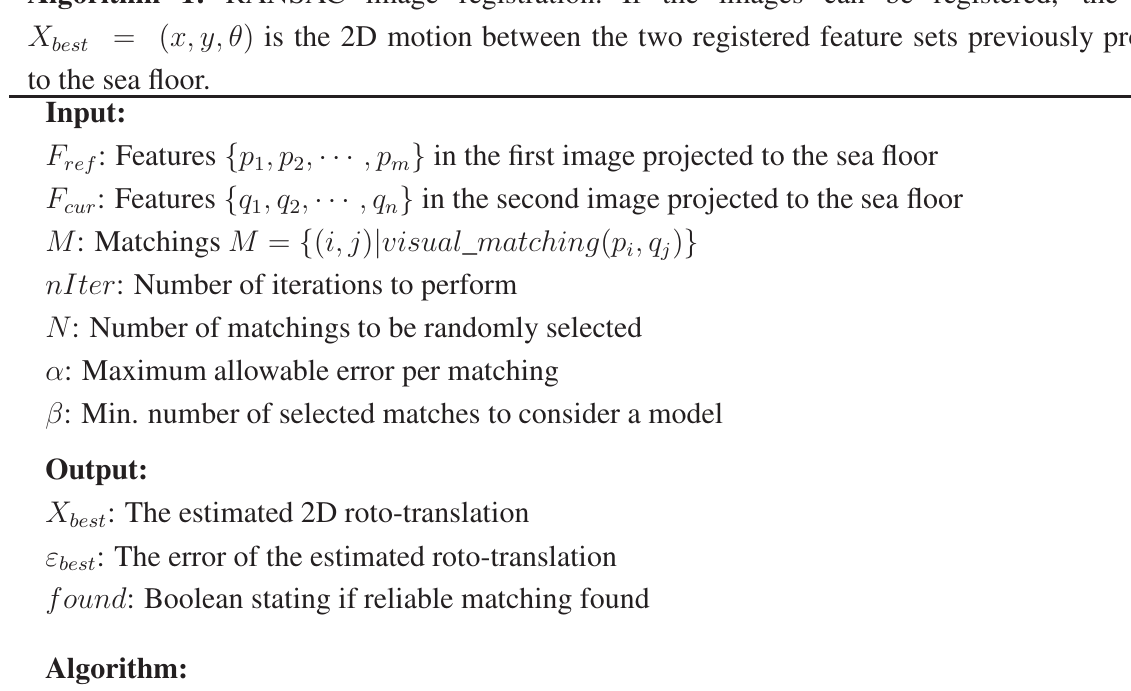
Algorithm 1: RANSAC image registration. If the images can be registered, the output X = ( x, y, θ ) is the 2D motion between the two registered feature sets previously projected best to the sea